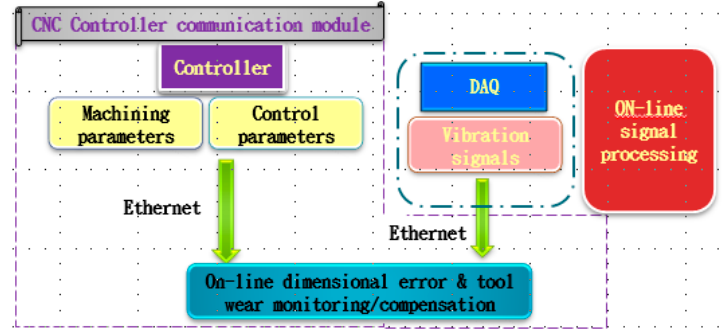
Figure 16. The communication module extracts information for monitoring/compensation.